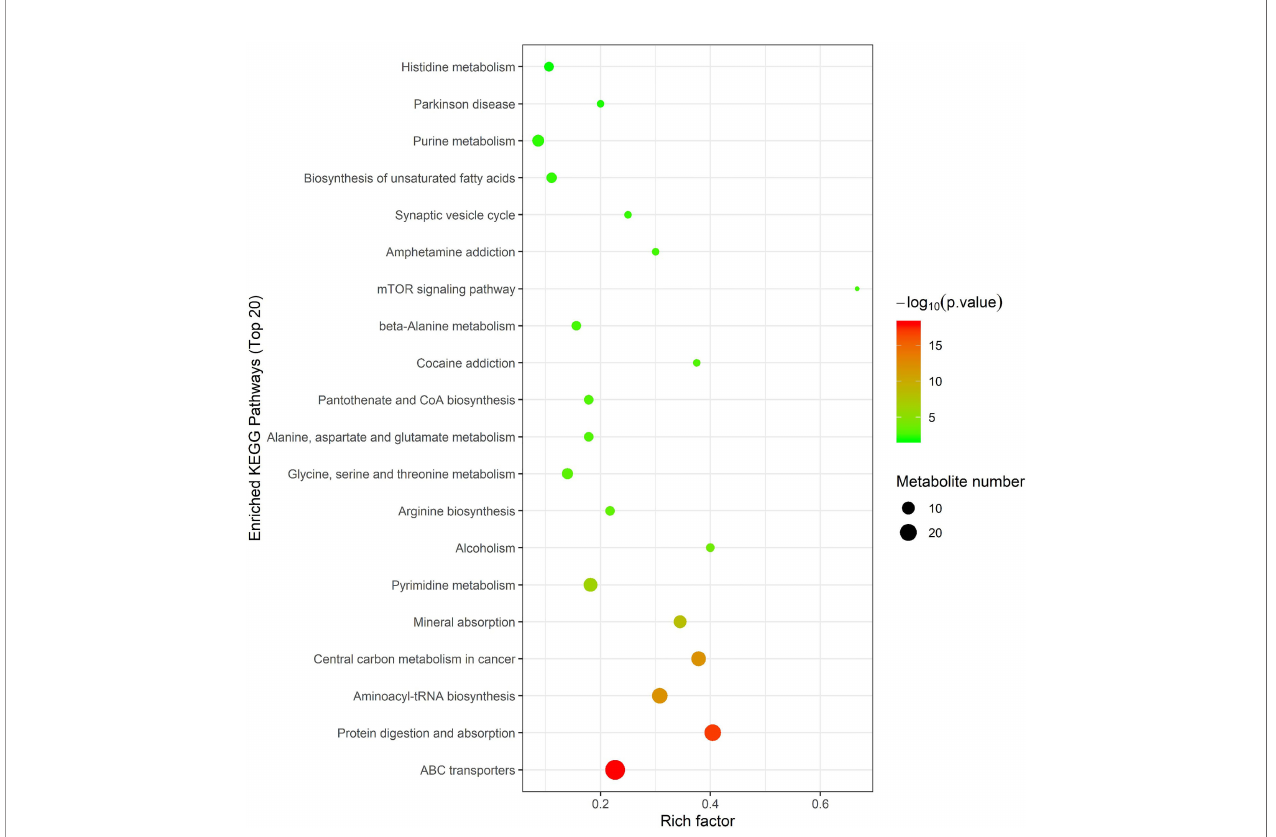
FIGURE 5 | Metabolic pathway analysis using MetaboAnalyst 4.0 (http://www.metaboanalyst.ca). x-axis: Rich factor, y-axis: metabolic pathway. Circle color represents -log 10 ( p-value ) and the size of the circle represent the number of metabolites enriched in metabolic